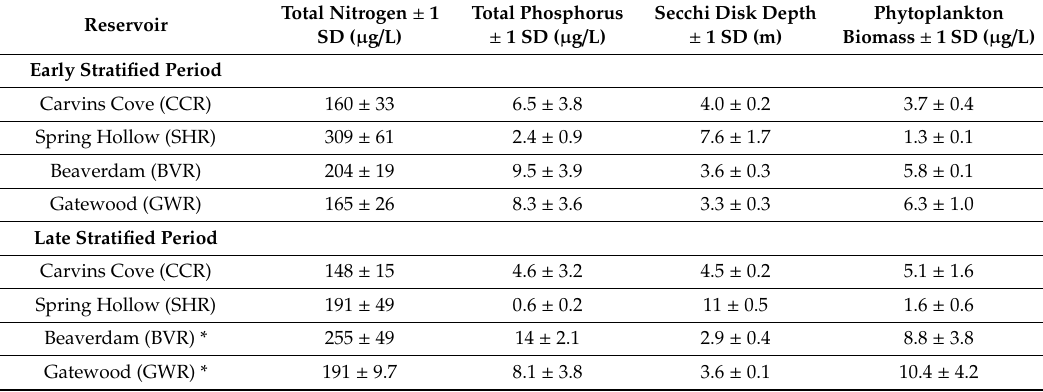
Table 3. Water quality characteristics of the four reservoir study sites between the early and late stratified periods across the sampling years. The delineation of the early and late stratified period in Carvins Cove and Spring Hollow was 20 July each year. In Beaverdam and Gatewood, the early and late stratified period was determined by the date of the onset of hypolimnetic hypoxia each year (Table A1). Total nitrogen and total phosphorus data are means ± 1 standard deviation (SD) from subsurface (0.1 m) water sampling. Secchi disk depth is the mean of the Secchi disk depths recorded from each